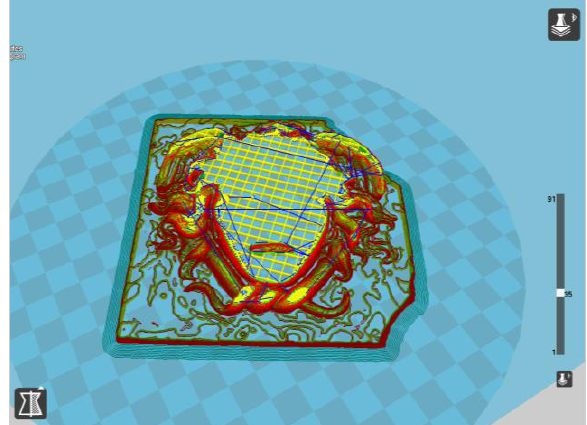
Figure 10. The main screen of Cura; the Medusa mask, horizontal position, layers view model